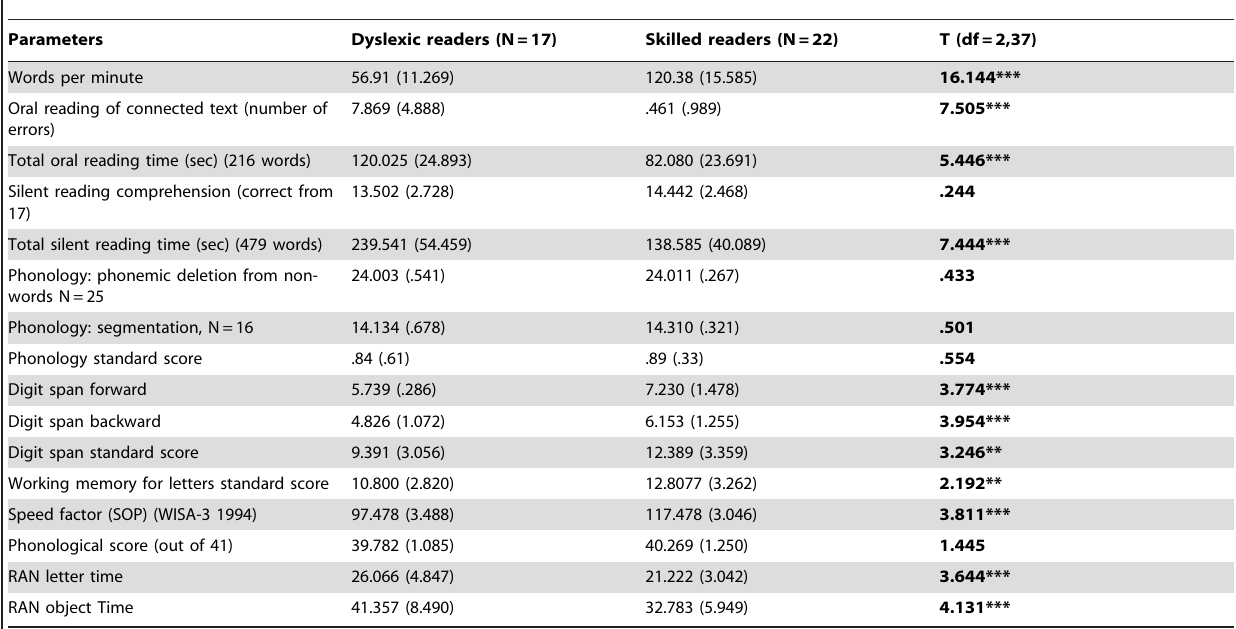
Table 1. Mean, (standard deviation) and between groups t-test results of dyslexic and regular readers on the baseline measures.